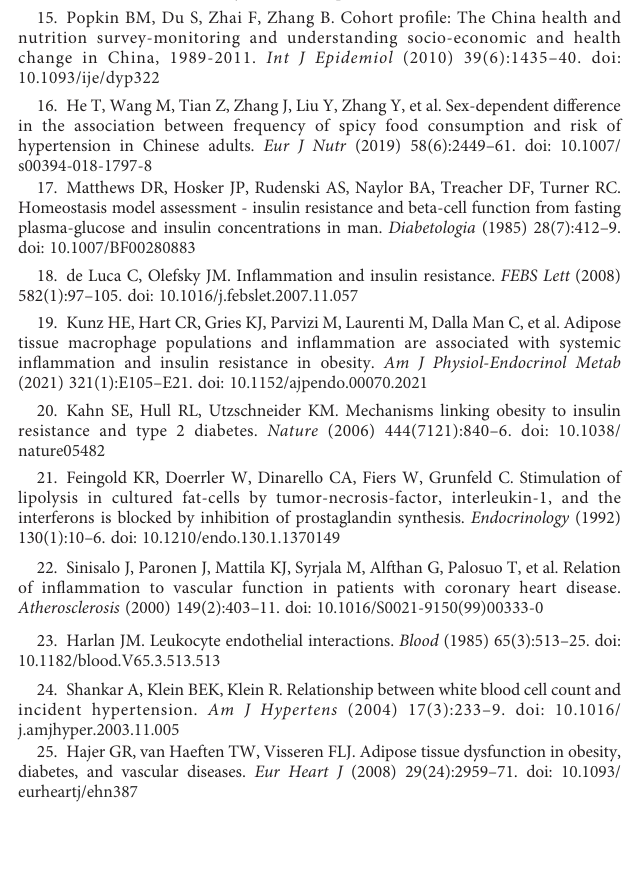
SUPPLEMENTARY FIGURE 1 Violin plot of components of MS based on different WBC category among all